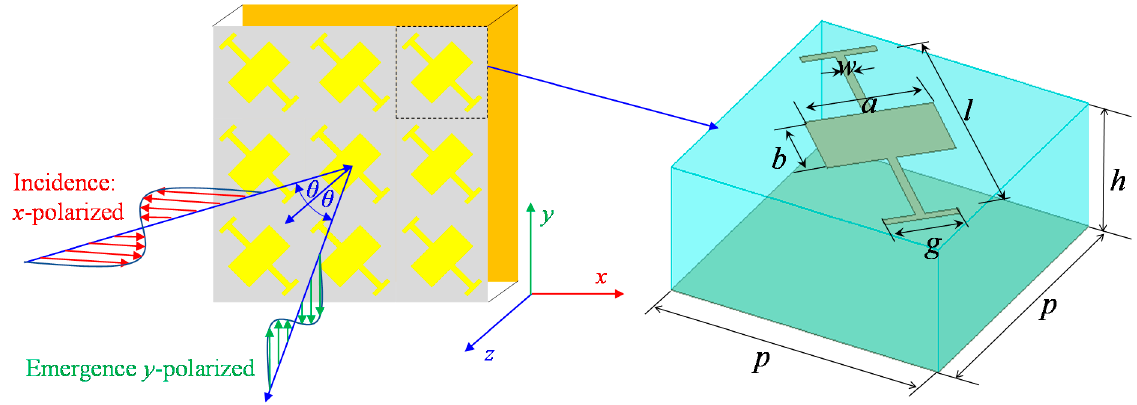
Figure 1. An illustration of the polarization rotator. Left panel: a demonstration of x -polarized wave incident on the periodical structure with emergence y -polarized wave; right panel: the unit cell of the polarization